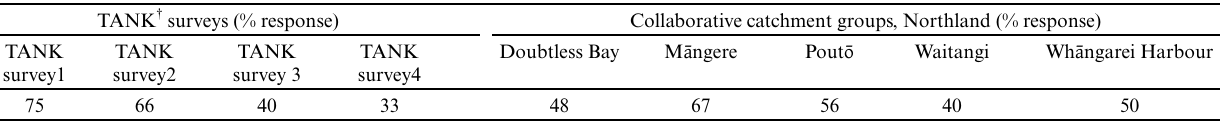
Table 3 . Summary of survey response